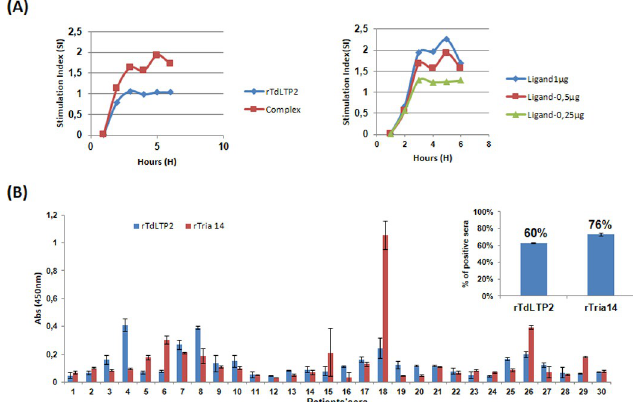
Fig 6. Detection of IgE patients’ sera binding to rTdLTP2. (A) Activation assay using the transfected cell line THP1-XBlue ™ . Cells were incubated with each ligand in triplicates and the activation was measured using QUANTI-Blue ™ . Results were represented by the stimulation index, referenced to the negative control (PBS), The threshold was established as the negative control +3SD. (B) Patients were sensitized to Tri a 14 with 76% (23) from a total of 30 sera. Each bar indicates the mean and SD of the inhibition percentage obtained with bakers’ sera from Spanish patients. 60% (18) sera for Tri a 14 were positives to rTdLTP2 and evaluated as significant. Threshold was calculated as the negative control+